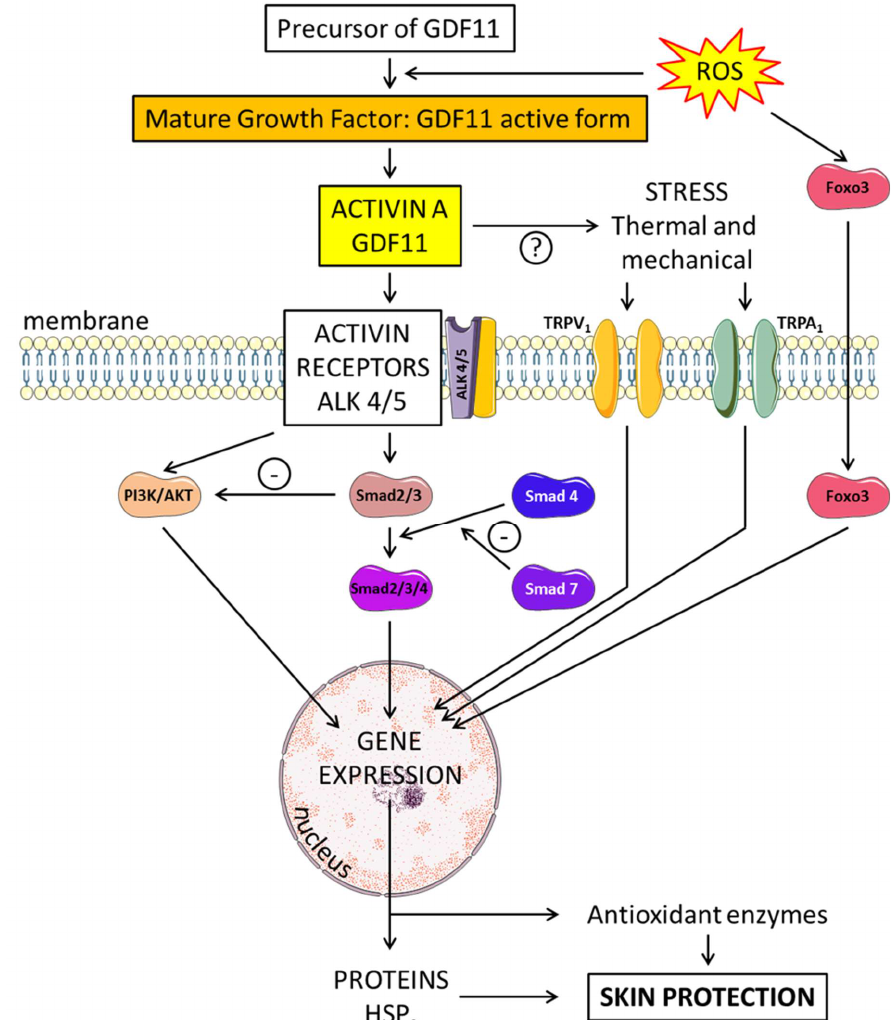
Figure 2. Schematic overview of the skin-protecting properties of GDF11. Mature GDF11 binds to activin receptor II (ActRII), including ActRIIA and ActRIIB, and then recruits activin receptor I (ActRI), including ALK4, and ALK5. Members of the Smad family of transcription factors are important intracellular messengers. The type I receptor subsequently phosphorylates Smad 2 or 3, allowing this complex to associate with Smad 4. This Smad complex, Smad2 / 3 / 4, is then localized to the nucleus. The Smad complex acts in the nucleus on target genes regulating transcription. The phosphatidylinositol 3-kinase (PI3K) / AKT pathway (PI3K / AKT), p27kip1and IL-23 are implicated. Proteins (heat shock proteins: HSPs) and antioxidant enzymes are produced. Foxos translocate to the nucleus where they activate programs of gene expression. Foxo3 is involved in counteracting oxidative stress. Gene expression is modified after stimulation of the transient receptor potential vanilloid 1 (TRPV1) and ankyrin 1 (TRPA1)